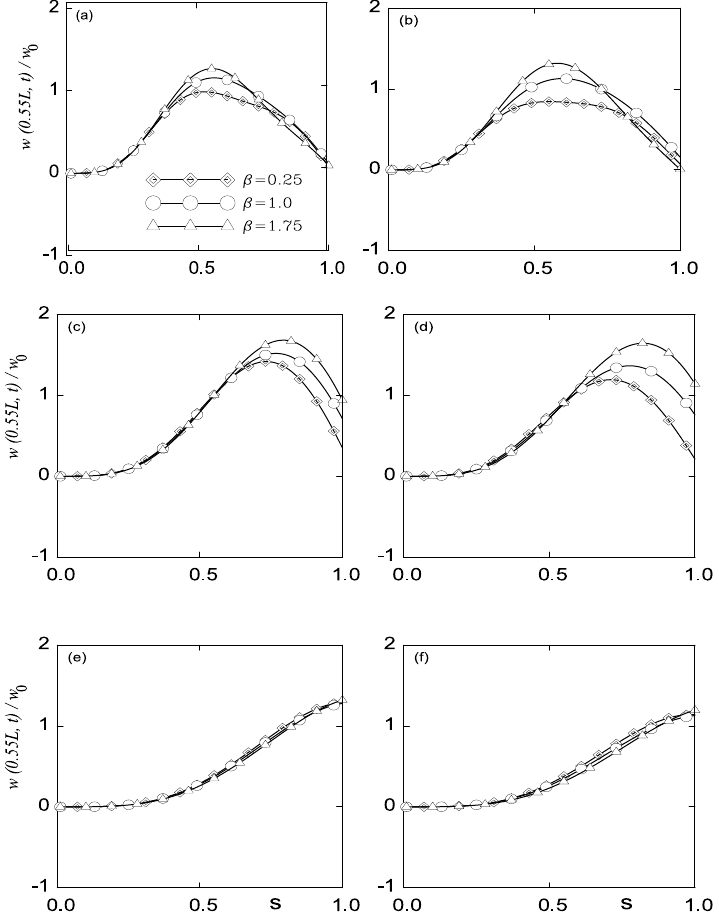
Fig. 6. Dynamic response ( w (0 . 55 L,t ) /w 0 ) for a fi xed-hinged beam: (a) α = 0.25, ζ n = 0.1, (b) α = 0.25, ζ n = 0.2, (c) α = 0.5, ζ n =